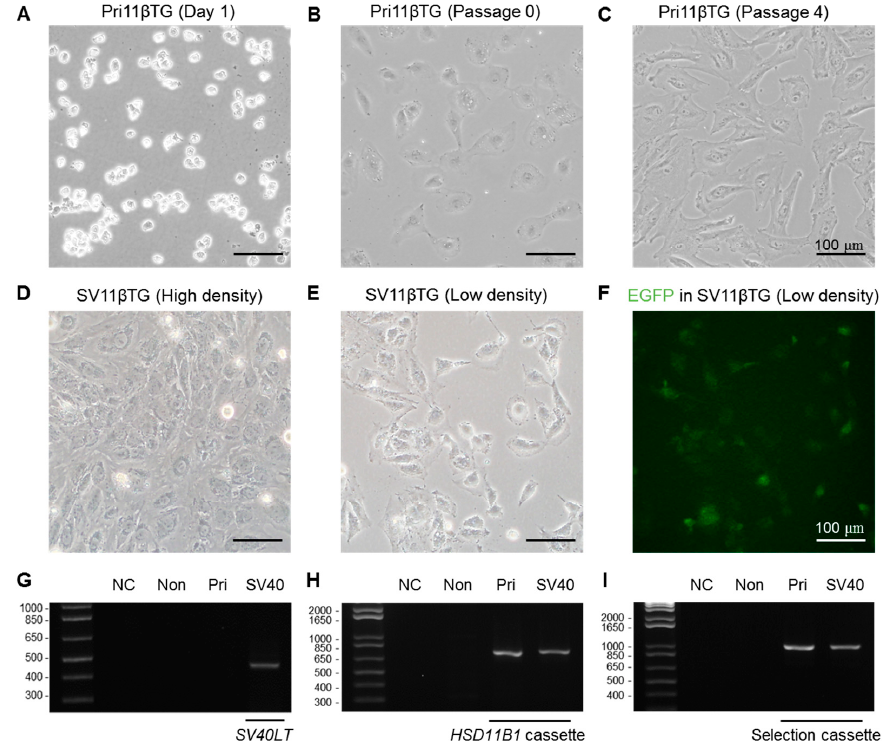
Figure 1. Morphological change and PCR-based confirmation of genomic integration in immortalized SV11 β TG hepatocytes. ( A – C ) Accordance with the progression of passages (one day after cell isolation ( A ), the zero passage ( B ), and the fourth passage ( C )), morphology of Pri11 β TG hepatocytes became longer and fibroblast-like, and the size of hepatocytes increased; ( D – F ) Morphology and size of the SV11 β TG hepatocytes, which were immortalized by SV40 large T antigen, recovered similar to Pri11 β TG ones at the first passage in high density ( D ) and low density ( E ); EGFP expression ( F ) was confirmed in 11 β TG hepatocytes due to the selection cassette including EGFP and neomycin resistance gene ( Neo r ) [7] (Scale bar, 100 µm); ( G – I ) Chromosomal insertion was confirmed by PCR using primers flanking the target cDNA in SV40LT sequences ( G ) for immortalization, in HSD11B1 expression cassette ( H ) and in selection cassette ( I ). (NC, negative control without template; Non, non-transgenic hepatocytes; Pri, Pri11 β TG hepatocytes; SV40, SV11 β TG hepatocytes; SV40LT , SV40 large T antigen).